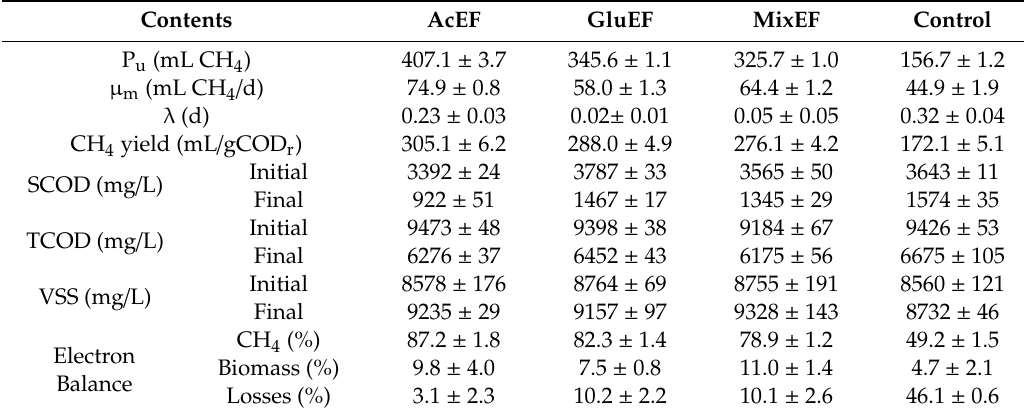
Table 1. Summary of methane production, physicochemical properties, and electron balance in the repeated sequential batch